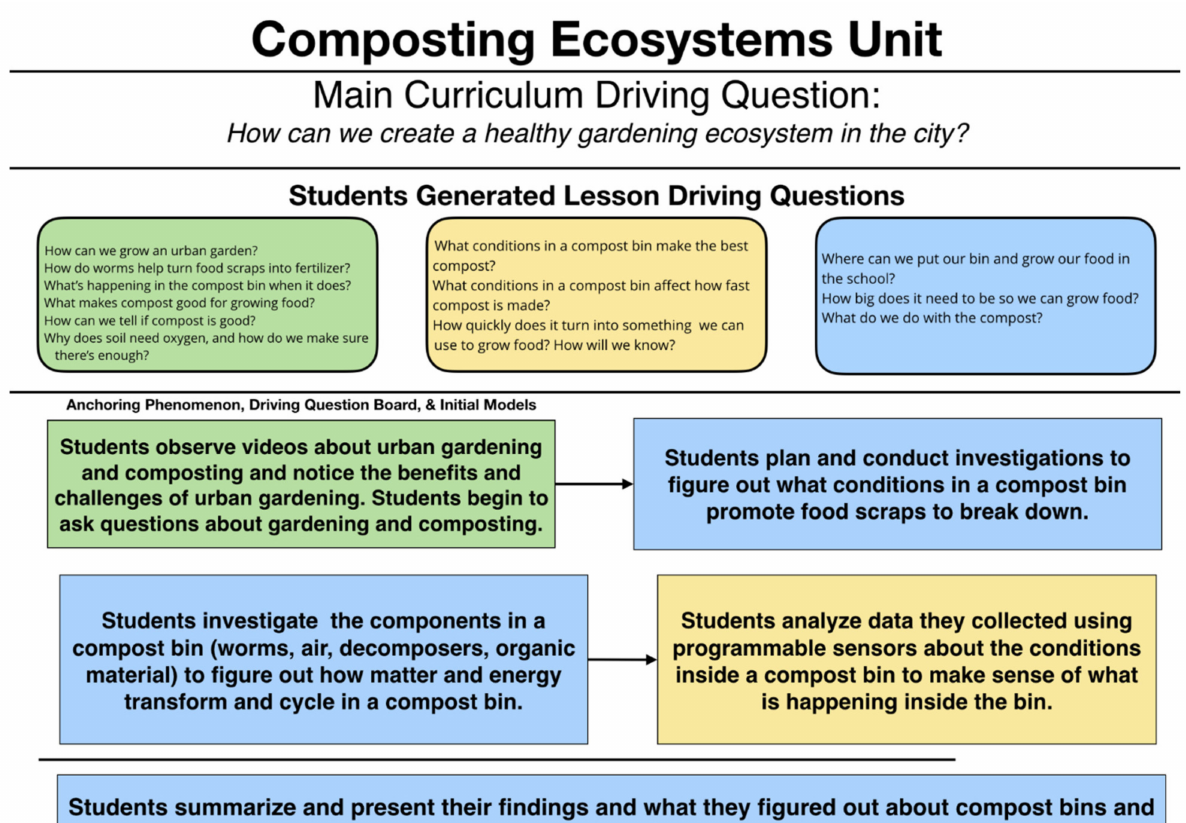
Figure 4. The overall flow of the Composting Ecosystems Unit and an overview of the content of each of the six lessons comprising the instructional